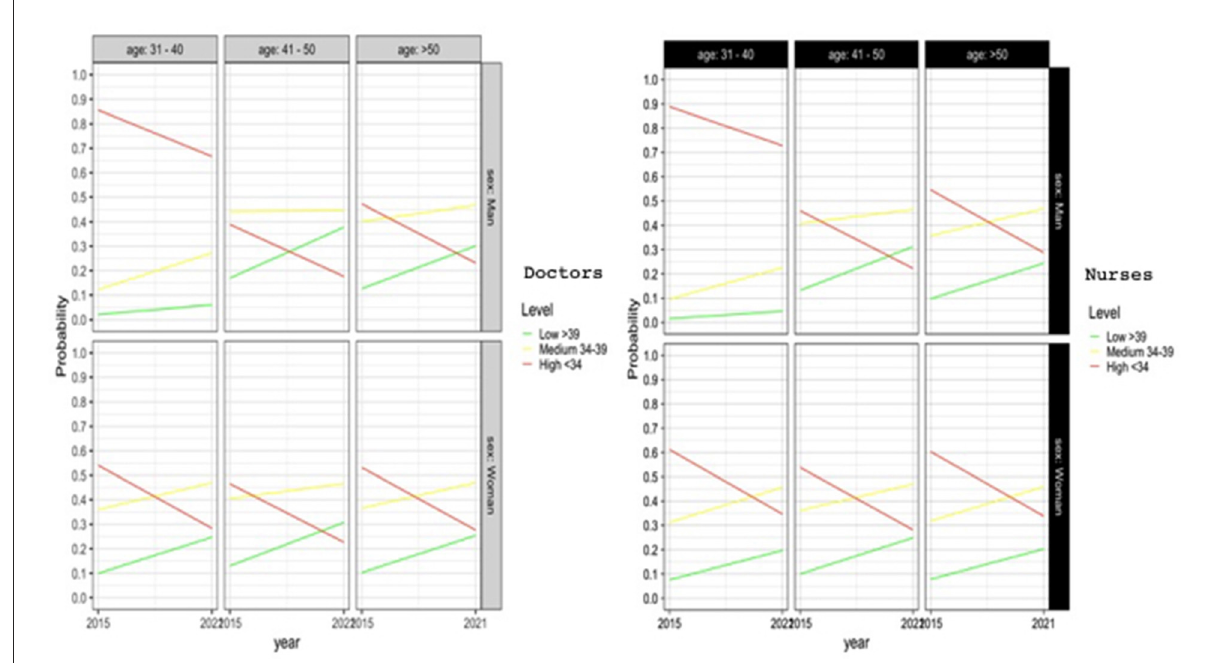
FIGURE2 Logistic regression model for depersonalization.